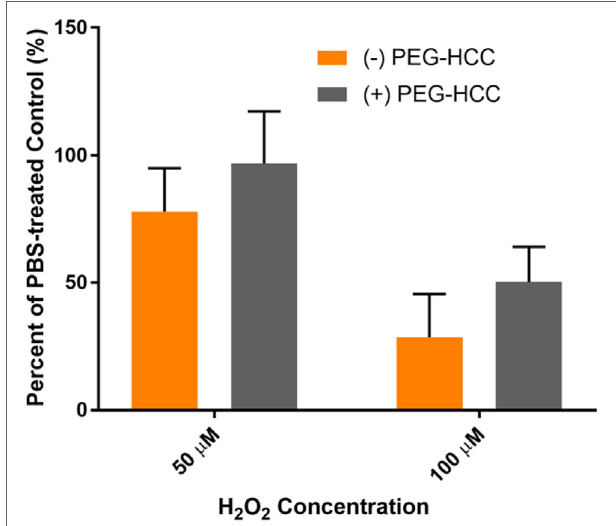
FigUre 2 | Hydrophilic carbon clusters, conjugated to poly(ethylene glycol) (PEG-HCCs) reduce cytotoxicity of H 2 O 2 on treated MCNs. PEG-HCCs given at a concentration of 8 mg/L treated immediately following exposure and overnight incubation reduce cell death restored cell number to baseline following 50 µM H 2 O 2 and doubled cell count following the much more toxic 100 μ M H 2 O 2